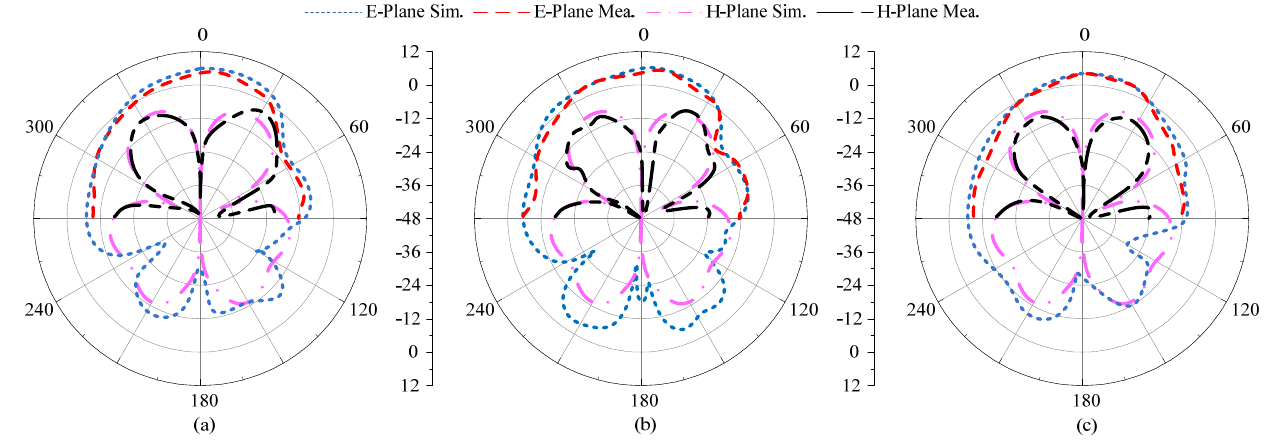
Figure 10. Comparison of the measured and simulated radiation pattern in E and H plane of proposed MIMO antenna at ( a ) 27 GHz ( b ) 28 GHz ( c ) 29 GHz.